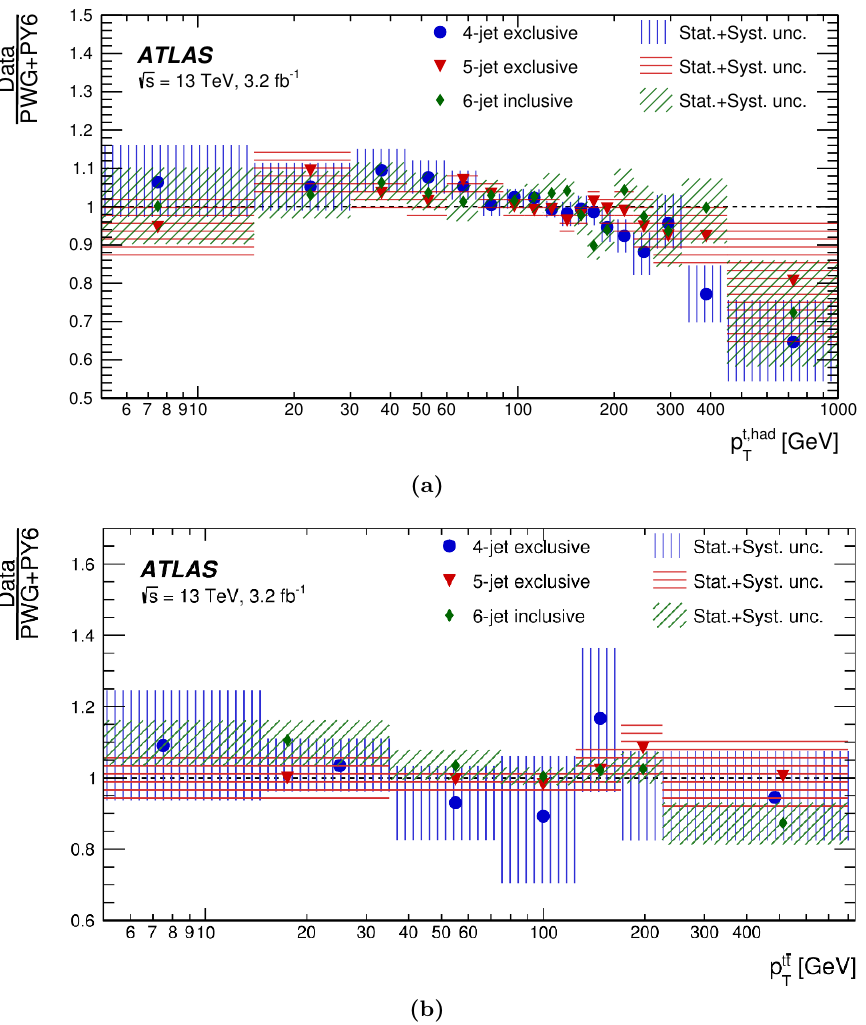
Figure 12 . Normalised (a) ratio of data to the nominal prediction as a function of p t; had